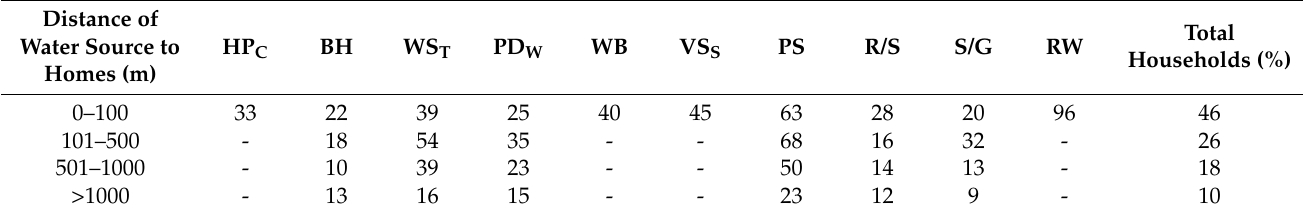
Table 3. Percentages of households with multiple water sources at various distances.